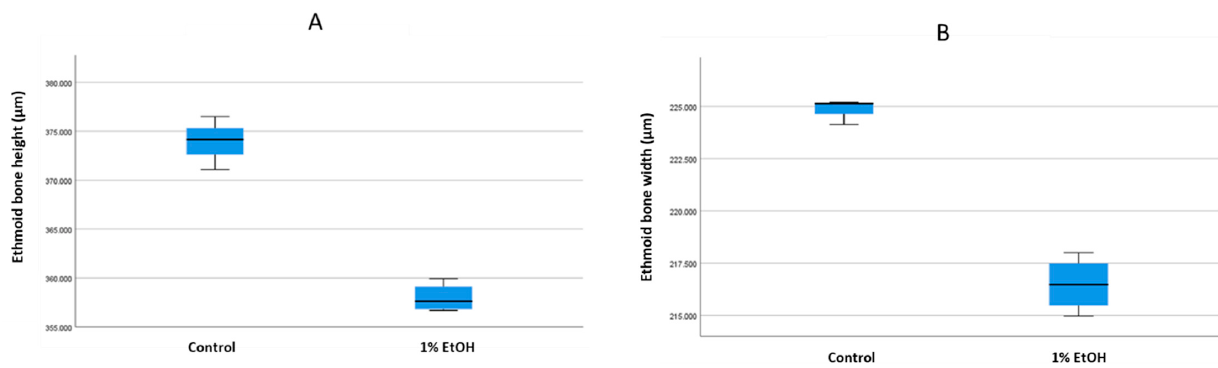
Figure 5. Comparing the ethmoid bone ( A ) height and ( B ) width in 10 days post-fertilisation (dpf) control and 1% alcohol-treated zebrafish samples. In ( A ), the mean length was 373.91 µm for control group and 357.97 µm for the 1% alcohol-treated group. There was a significant difference ( p < 0.05) between the groups. In ( B ), the mean width was 224.80 µm for control group and 216.47 µm for 1% alcohol-treated group. There was a significant difference the groups.